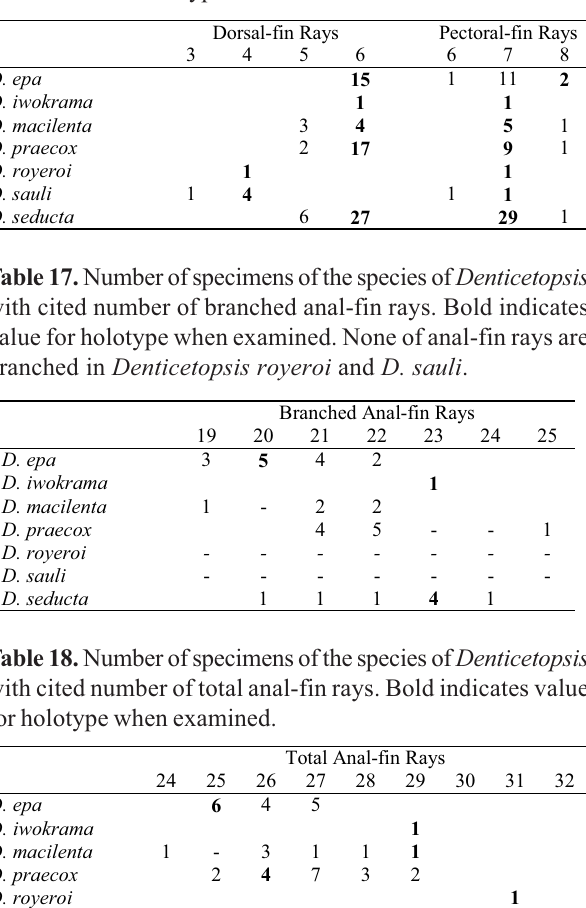
Table 16. Number of specimens of the species of Denticetopsis with cited number of dorsal and pectoral-fin rays. Bold indi- cates value for holotype when examined.